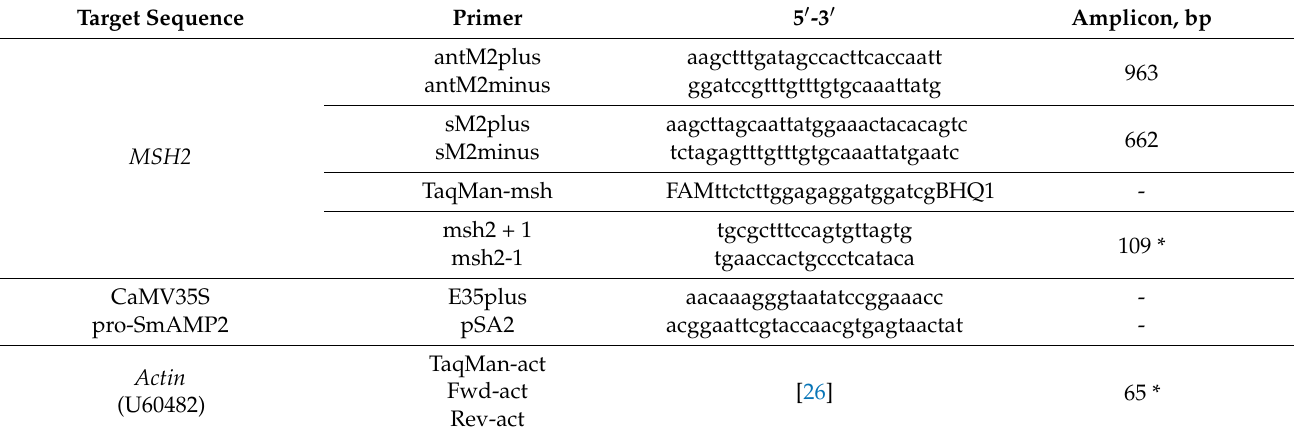
Table 1. Primers for the creation of genetic constructs and molecular analysis of transgenic plants. Target